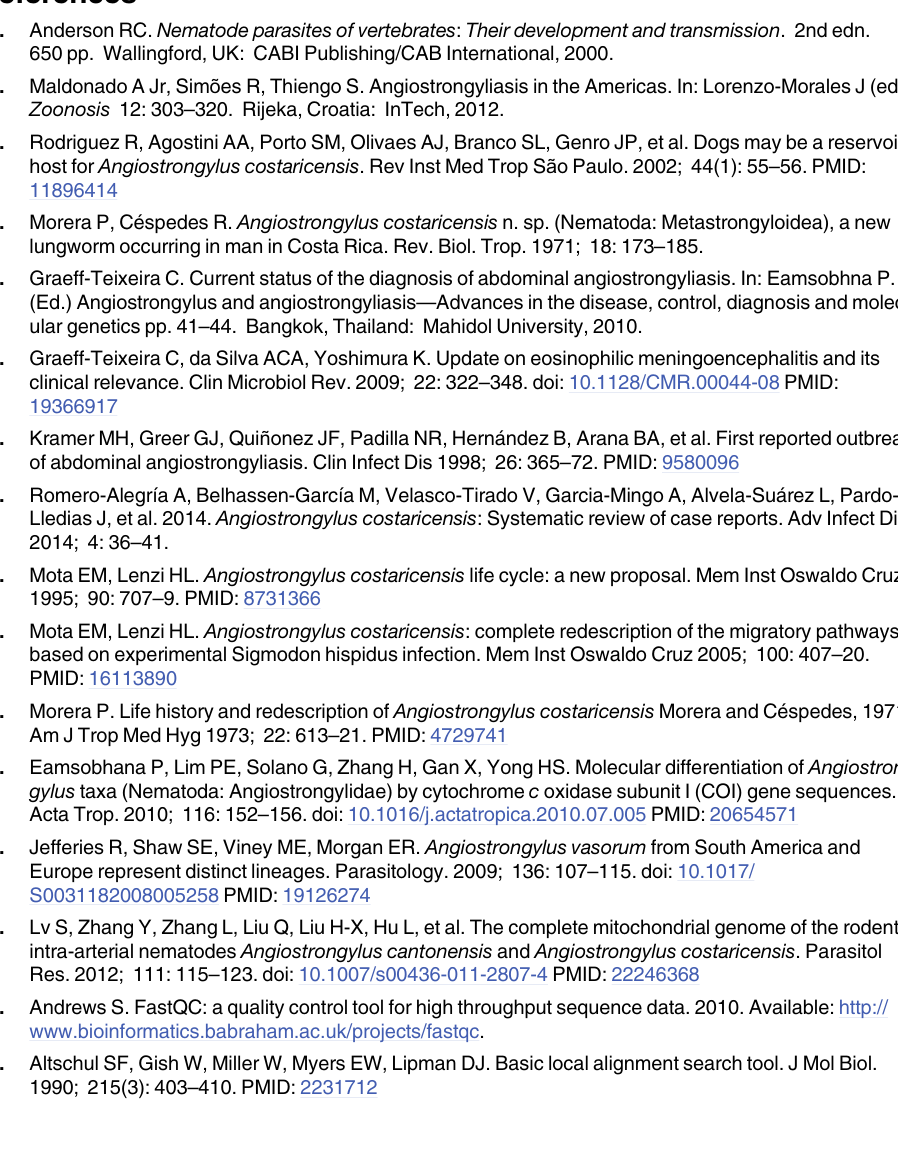
of Angiostrongylus costaricensis